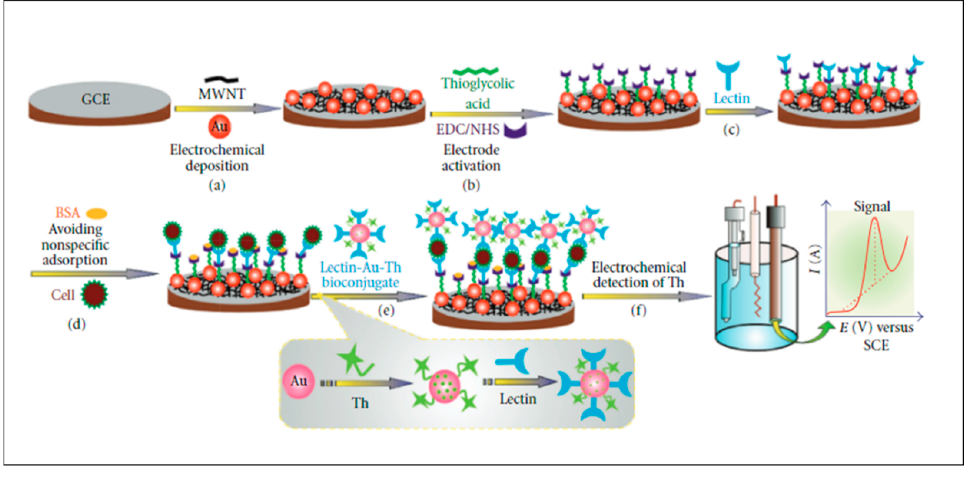
Figure 8. Schematic of synthesis and application of a glycan electrochemical sensor. (Reproduced from Ref. [97] with permission from Hindawi).